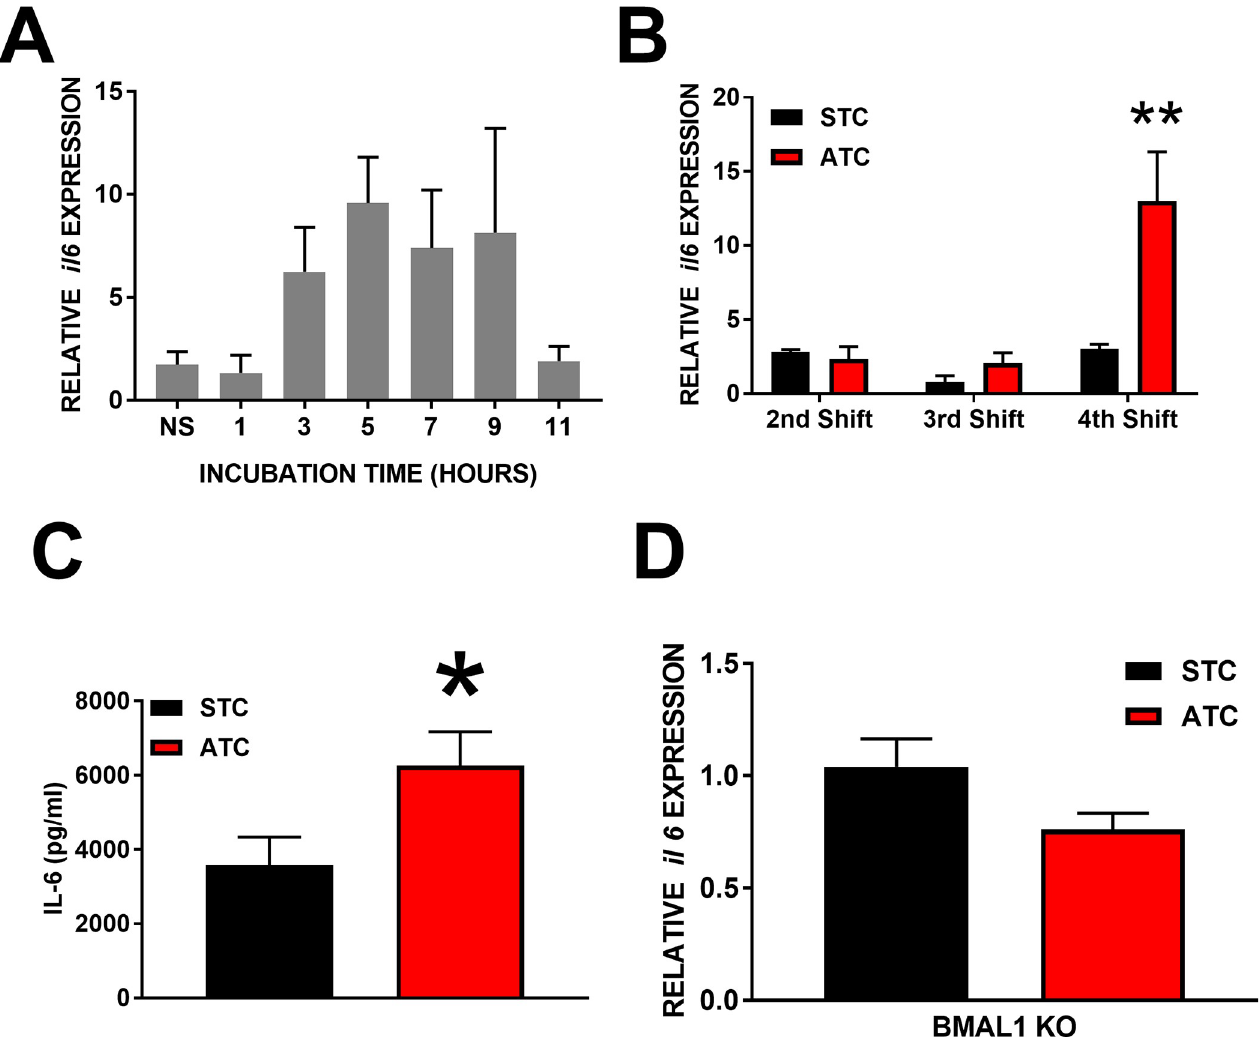
Fig 2. Immune consequences of circadian disruption in vitro . A: Induction of il-6 by LPS exposure of increasing duration following four 6hr phase advances (in hours; n = 6 per condition, NS signifies not stimulated with LPS). B: Induction of il-6 by LPS. Following 2, 3, or 4 six-hour phase advances (ATC; red; n = 6 per condition) or the same duration of a static temperature cycle (STC; black; n = 6 per condition), spleen explants were challenged with LPS for 6-hr. Significance determined by Two-way ANOVA. C: IL-6 protein secreted by spleen explants subjected to a 6-hr LPS challenge after being maintained in a static (STC; black; n = 6) or advancing (ATC; red; n = 6) temperature cycle (4 phase advances). Significance determined by ANOVA. D: Induction of IL-6 transcript by LPS in BMAL1KO spleen explants following either a static (STC; black; n = 6) or 4 shifts in an advancing (ATC; red; n = 6) temperature cycle (4 phase advances). Significance determined by Two-Way ANOVA (B) or Student’s T-Test (C and D). � p < 0.05; �� p < 0.01.